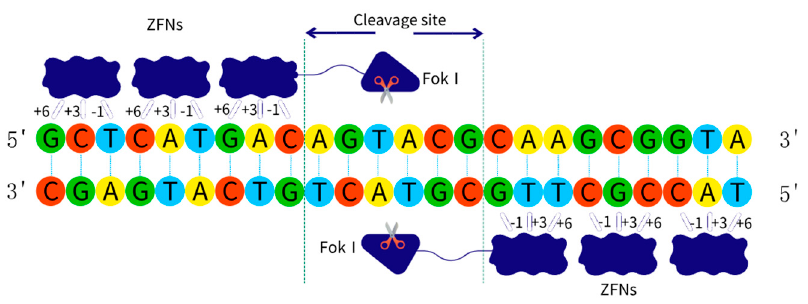
Figure 1. The schematic diagram of ZFNs.